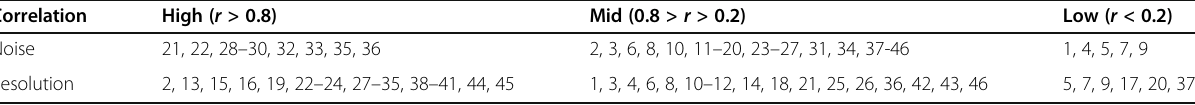
Table 4 Texture features linear correlation with noise and resolution Correlation